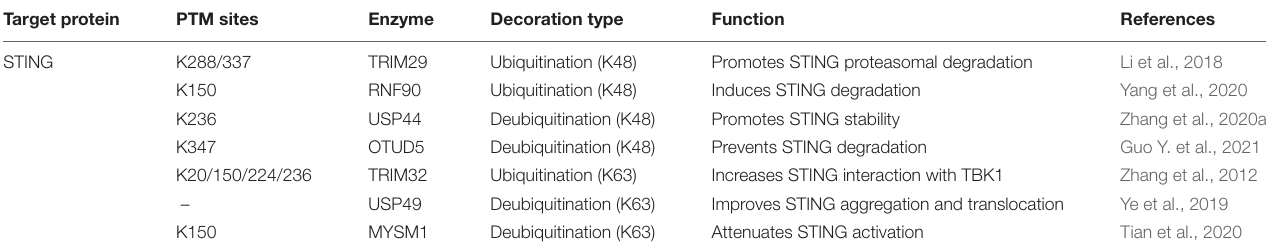
TABLE 2 | Dynamic ubiquitin decorations of STING.